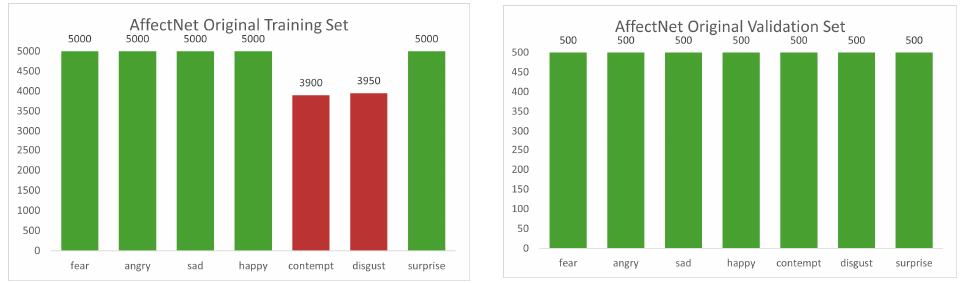
Figure 7. Distribution of classes in the AffectNet dataset; graph represents the mean values of green and red bars.